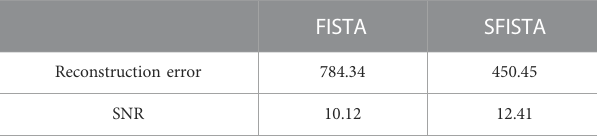
TABLE 1 Reconstruction error and SNR of different